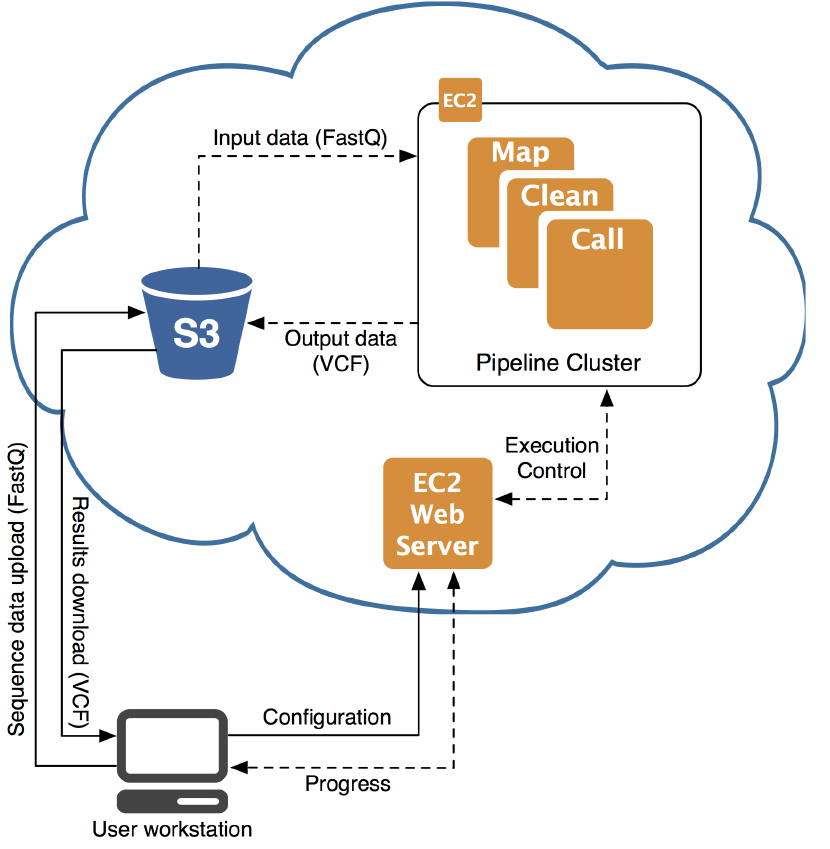
Figure 1. Overview of the STORMSeq system. The user uploads short reads to Amazon S3 and starts a webserver on Amazon EC2, which controls the mapping and variant calling pipeline. Progress can be monitored on the webserver and results are uploaded to persistent storage on Amazon S3.